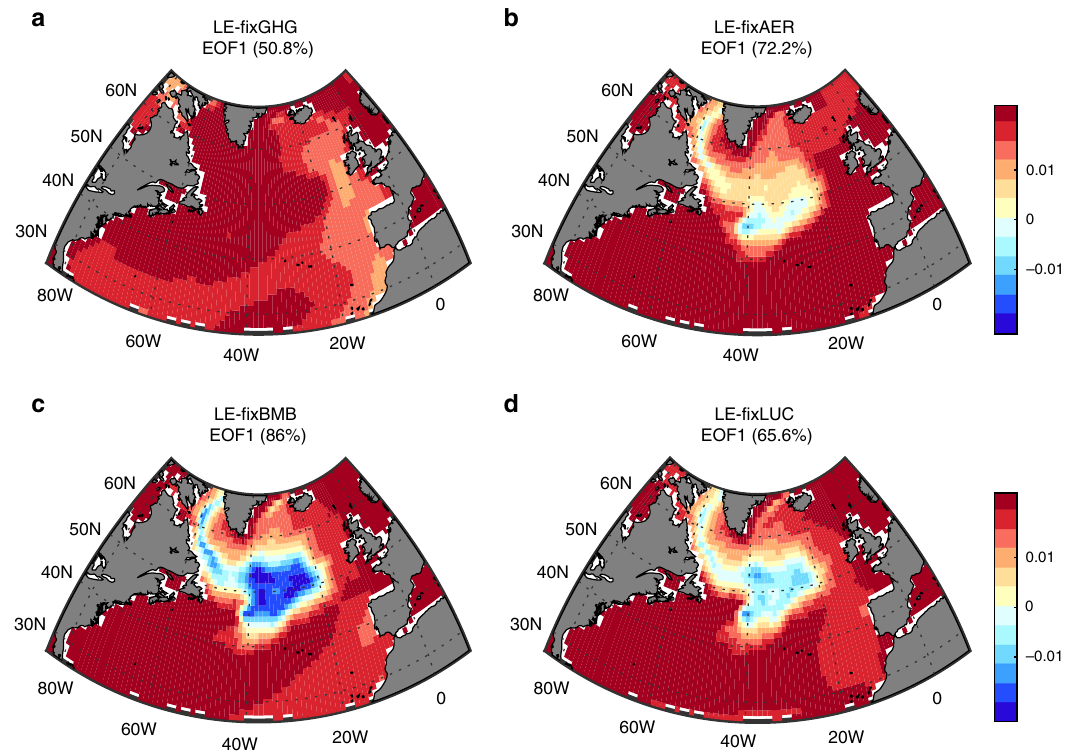
Fig. 3 Attribution analysis for North Atlantic sea surface temperature. The leading mode ( fi ngerprint) of the 1982 – 2017 North Atlantic sea surface temperature anomalies in the four Community Earth System Model (CESM) ensembles with a fi xed greenhouse gases (LE- fi xGHG), b fi xed aerosols (LE- fi xAER), c fi xed biomass burning (LE- fi xBMB), and d fi xed land use/change (LE- fi xLUC). The percentage in each panel represents the variability explained by each